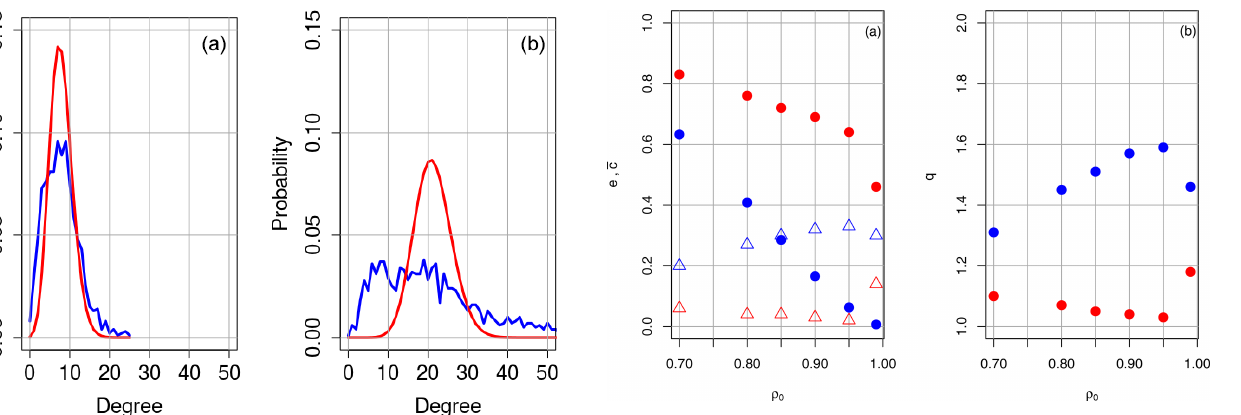
Figure 3. Node degree probability distribution for the SHY droughts in the GE region for the normal year 2013 (a) and the extreme year 2018 (b) . Blue shows the distribution according to the RCN, and red shows the Poisson distribution with parameter λ = d k (the average node degree).